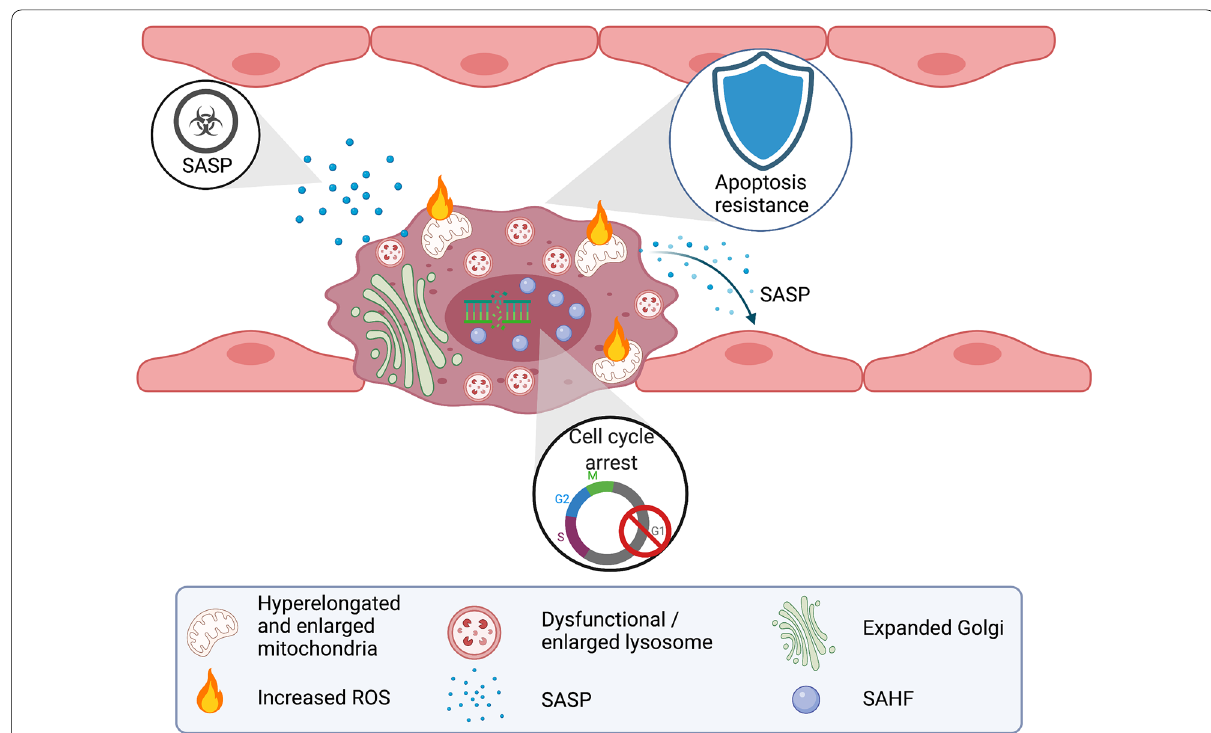
Fig. 3 Characteristics of senescent endothelial cell. Senescent cells become irregular and flat with cytoplasmic and nuclear enlargement, multiple organelle modifications, including enlarged and dysfunctional lysosomes enclosing lipid and protein aggregates. Senescent cells can exhibit hyperelongated mitochondria resulting from unbalanced mitochondrial fission and fusion thereby favoring ROS generation. An expanded Golgi apparatus is also observed, along with nuclear enlargement and chromatin condensation such as SAHF. Senescence‑associated dysfunction includes the SASP with autocrine and paracrine effects, the apoptosis resistance and cell cycle arrest. ROS reactive oxygen species, SAHF senescence‑associated heterochromatin foci, SASP senescence‑associated secretory phenotype